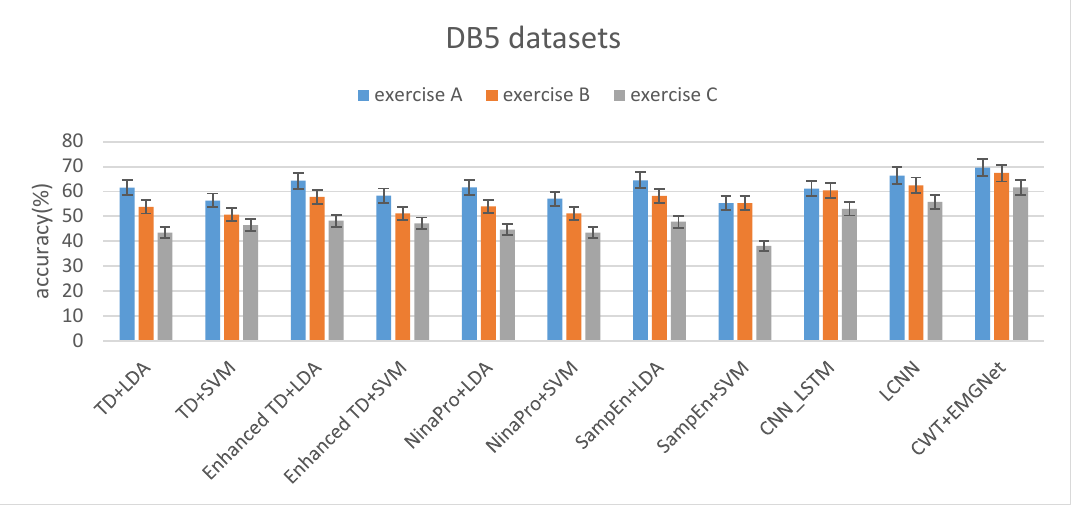
Figure 11. The average accuracy of three subsets on the DB5 Dataset.